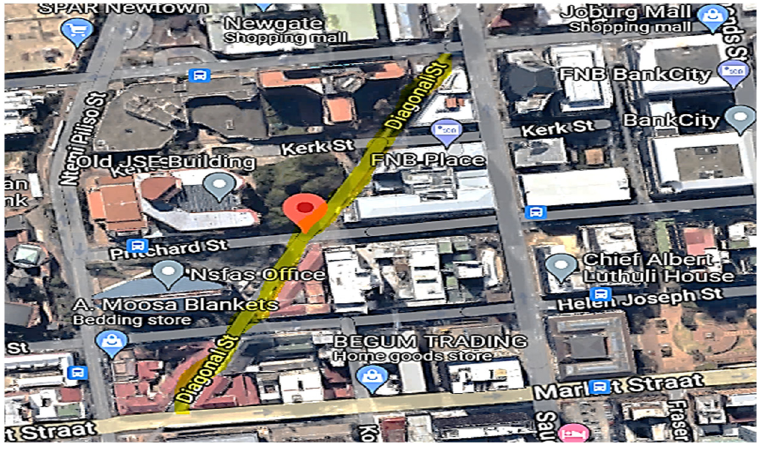
Figure 4. A map showing sampling location (HEG-3 market) in the inner city of Johannesburg [18].